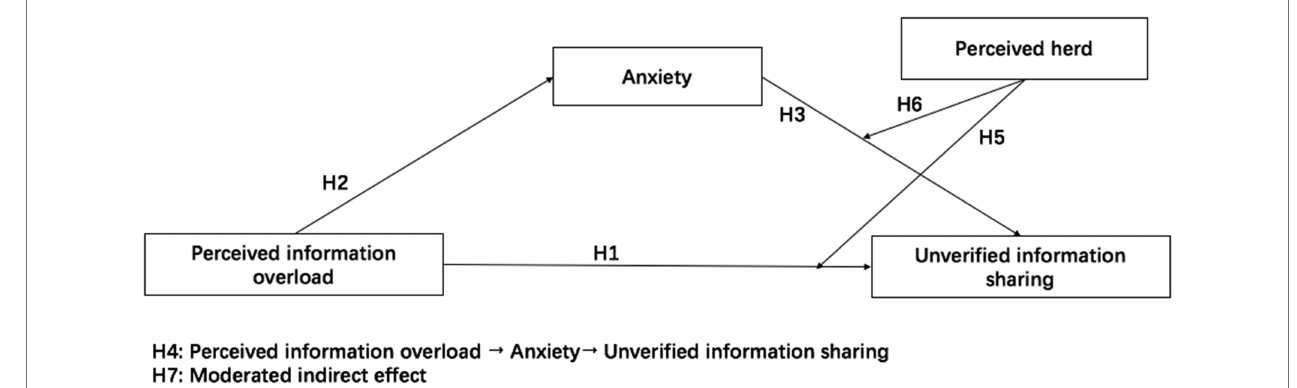
FIGURE 1 | Hypothesized